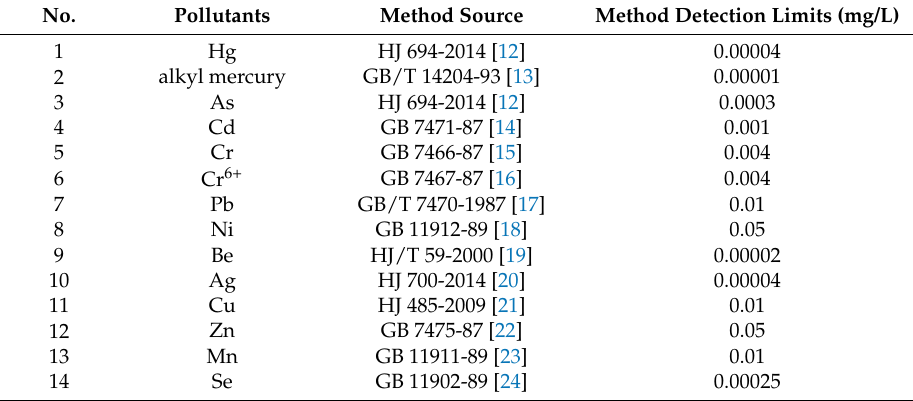
Table 1. Environment monitoring analytical methods used for analysis of 14 heavy metals and metalloids.